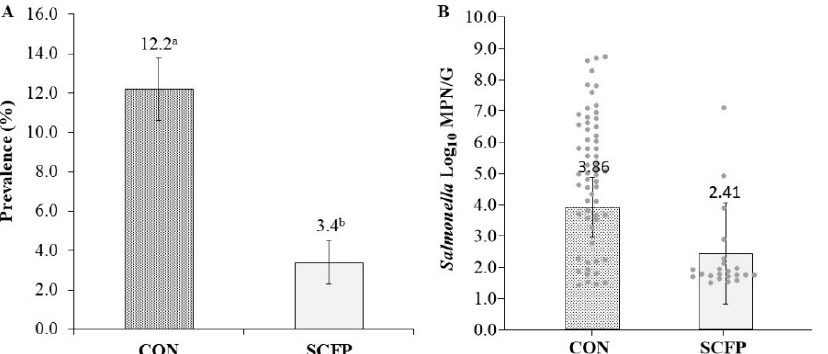
Figure 2. Treatment-level Salmonella enterica cecal prevalence ( A ) and load ( B ) LS means estimates. Error bars reflect prevalence estimate standard error and load estimate 95% confidence interval with significant differences denoted by superscripts a,b at p > 0.05.